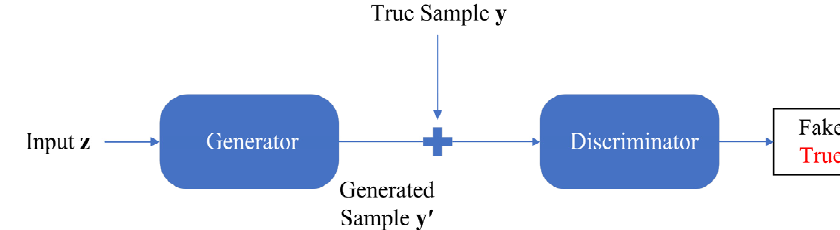
Figure 6. Basic structure of GAN.